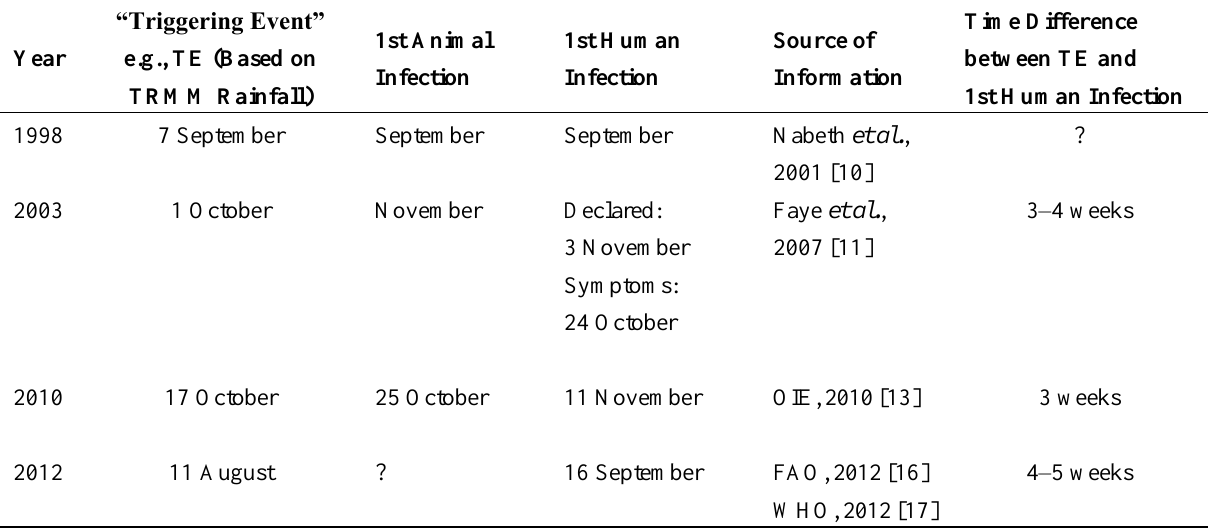
Table 1. RVF outbreak details for Mauritania